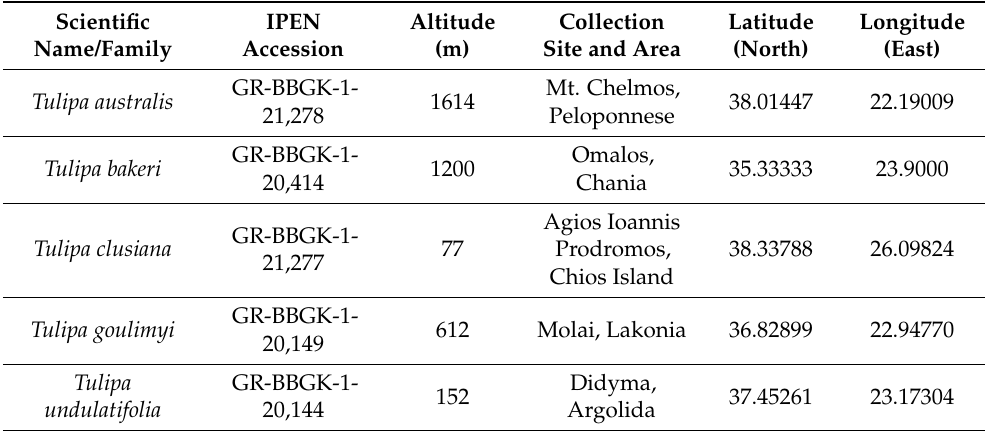
Table 3. Seed collection details and IPEN (International Plant Exchange Network) accession numbers regarding the Greek Tulipa spp. studied herein.